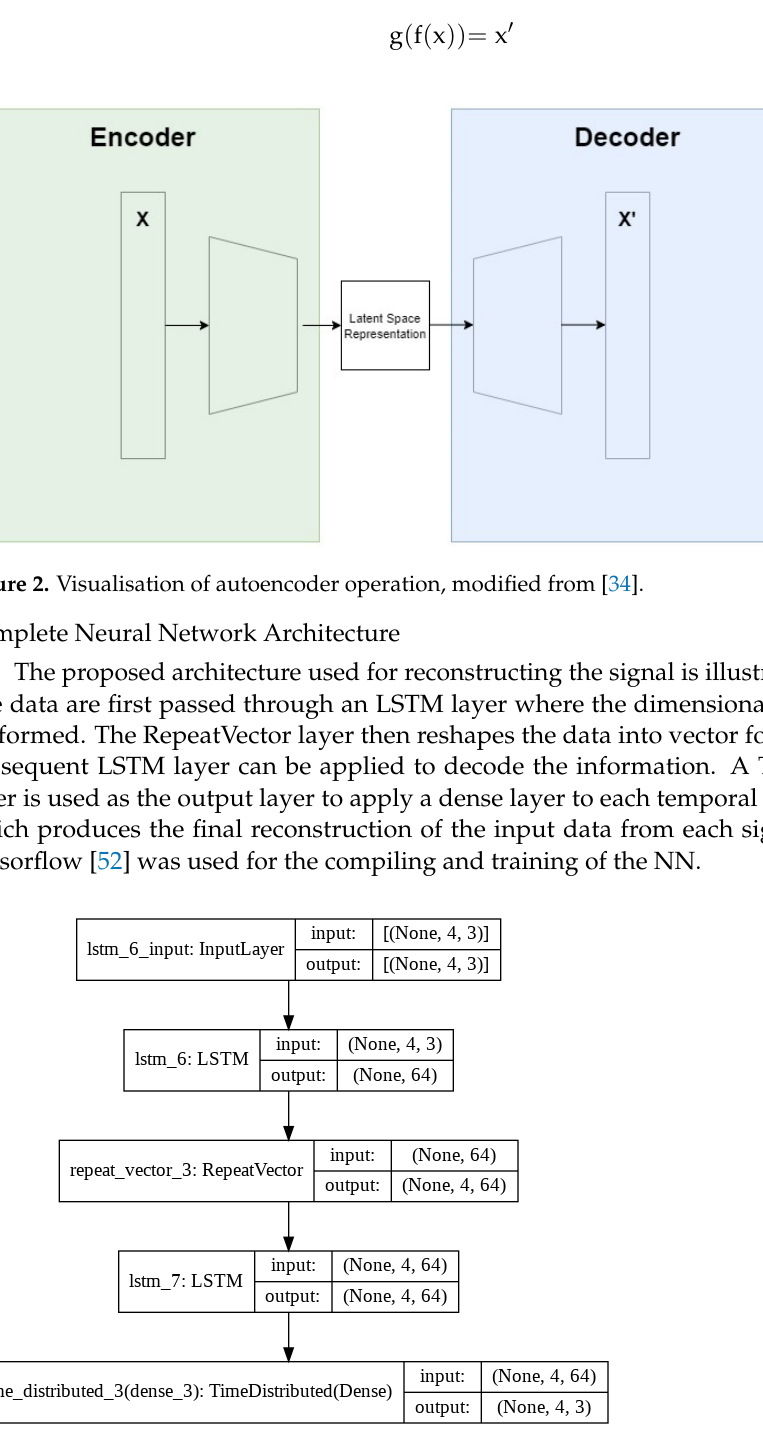
Figure 3. Proposed long-short-term-memory (LSTM) autoencoder model.